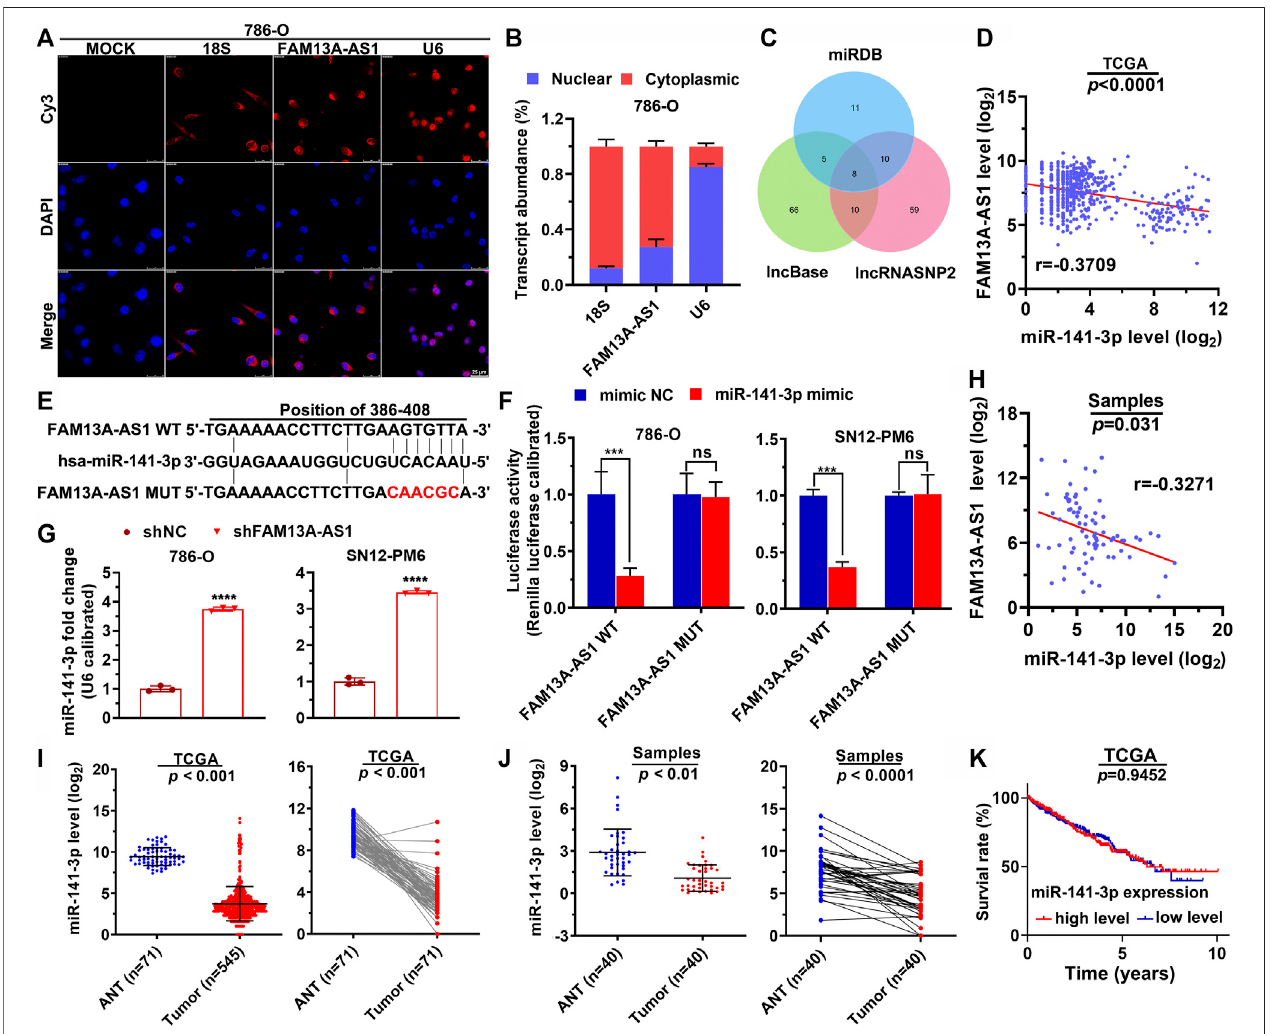
FIGURE 3 | FAM13A-AS1 functions as a ceRNA that competes for miR-141-3p. (A,B) Fish assay (A) and RT-qPCR (B) showing the subcellular expression (nucleus and cytoplasm) of FAM13A-AS1 in RCC cells, compared with 18S and U6 as the endogenous controls. (C) Venn diagram showing the intersection between computationally identi fi ed FAM13A-AS1 interacting miRNAs. (D) Scatter plot showing the co-expression pattern between miR-141-3p (Y-axis) and FAM13A-AS1 ( X -axis)inTCGA. (E) Schematic showingthepredicted miR-141-3pbindingsites inFAM13A-AS1wild-typetranscript,andtheFAM13A-AS1mutantescapingthe binding of miR-141-3p. The red nucleotides represent mutations on target sites. (F) Bar plot showing the luciferase activities in RCC cells co-transfected with wild-type (WT) or mutant (MUT) FAM13A-AS1 plasmid together with miR-141-3p mimic or negative control (NC). (G) Bar plots showing the miR-141-3p expression in RCC cells transfected with shFAM13A-AS1 or negative control (NC). Expression levels were measured using RT-qPCR. (H) Scatter plot showing the co-expression pattern between miR-141-3p (Y-axis) and FAM13A-AS1 ( X -axis) in and our own cohorts. (I,J) Scatter plots showing the miR-141-3p expression in normal and tumor tissues of RCCpatientfromTCGA (H) andourown (I) cohorts. (K) Kaplan-MeieranalysisoftheoverallsurvivalrateofRCCpatientsstrati fi edbytheexpressionofmiR-141-3pfrom TCGA cohort. Data represent the mean ± SD. ***: p < 0.001; ****: p < 0.0001.